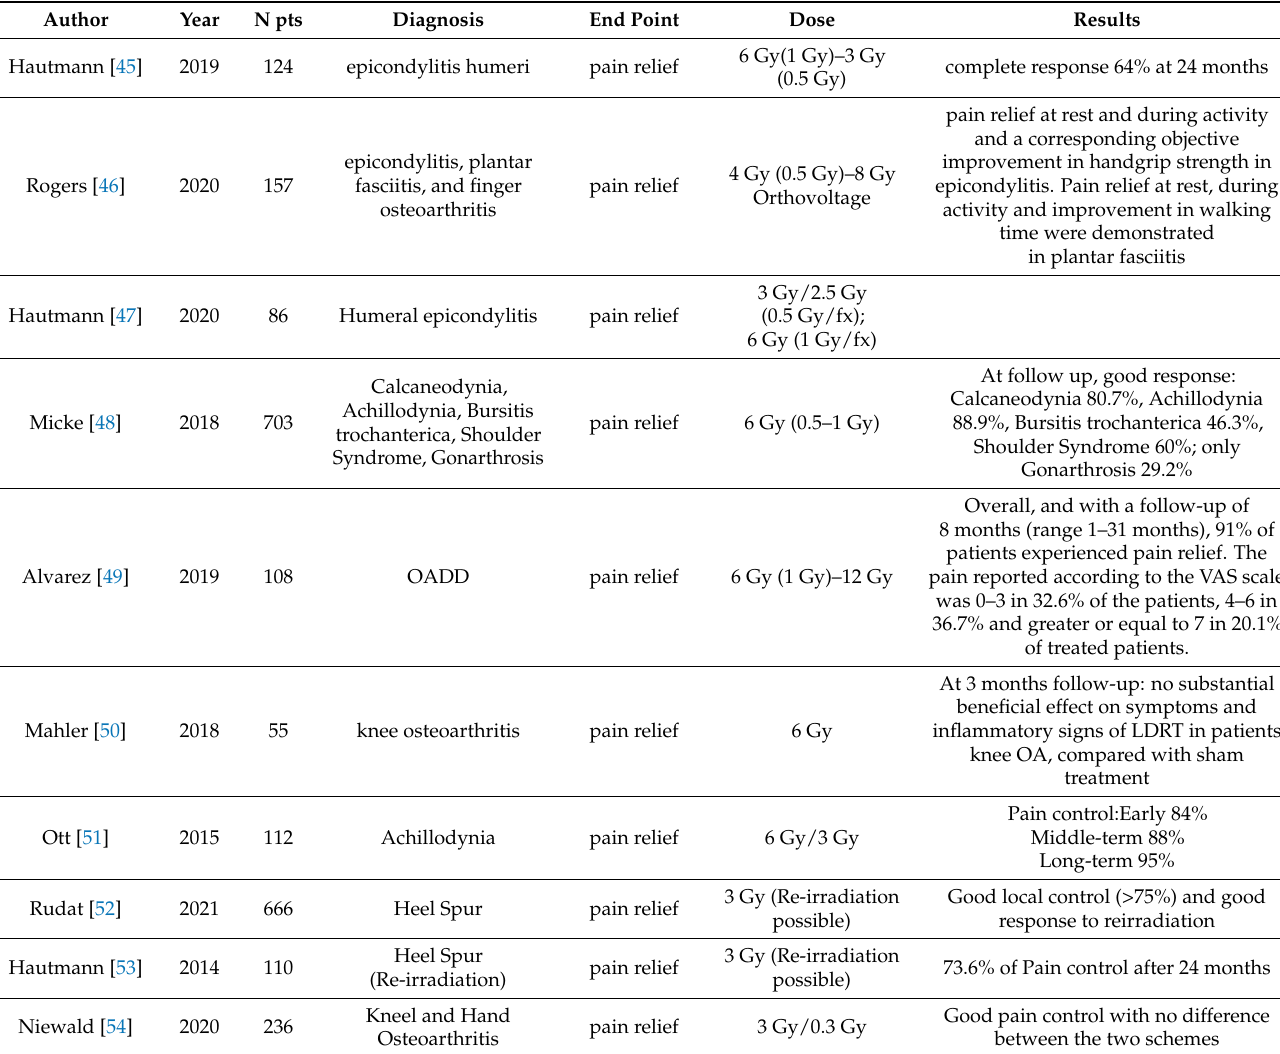
Table 3. Muscle-skeletal disorders: included study and radiotherapy